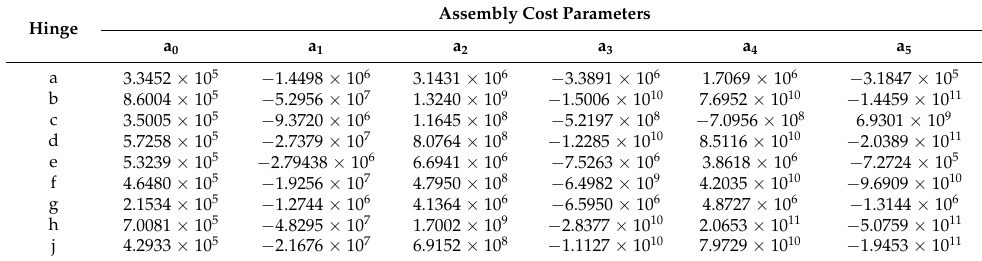
Table 5. LSDM assembly cost